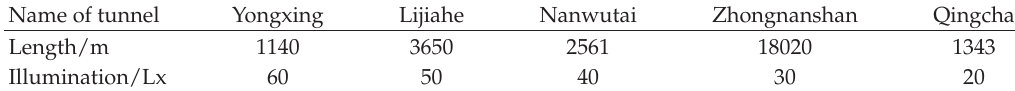
Table 1: Tunnels length and luminosity in middle segment.